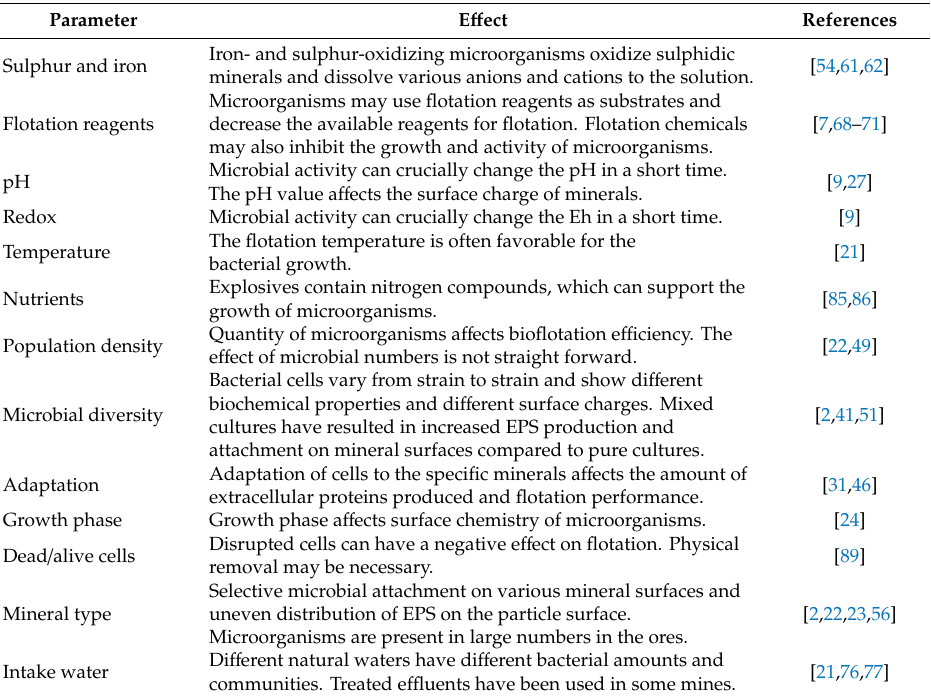
Table 2. Parameters a ff ecting flotation